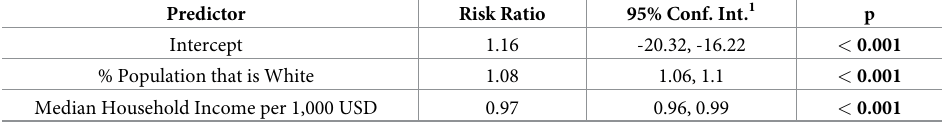
Table 5. Significant predictors of county-level LACV-ND risk in Ohio, West Virginia, North Carolina, and Ten- nessee from